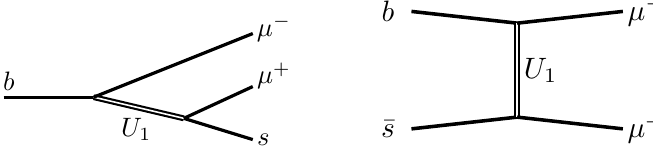
Figure 15 . Diagrams for the tree-level LQ contributions to the R ( ∗ ) (right). The two contributions are related via crossing